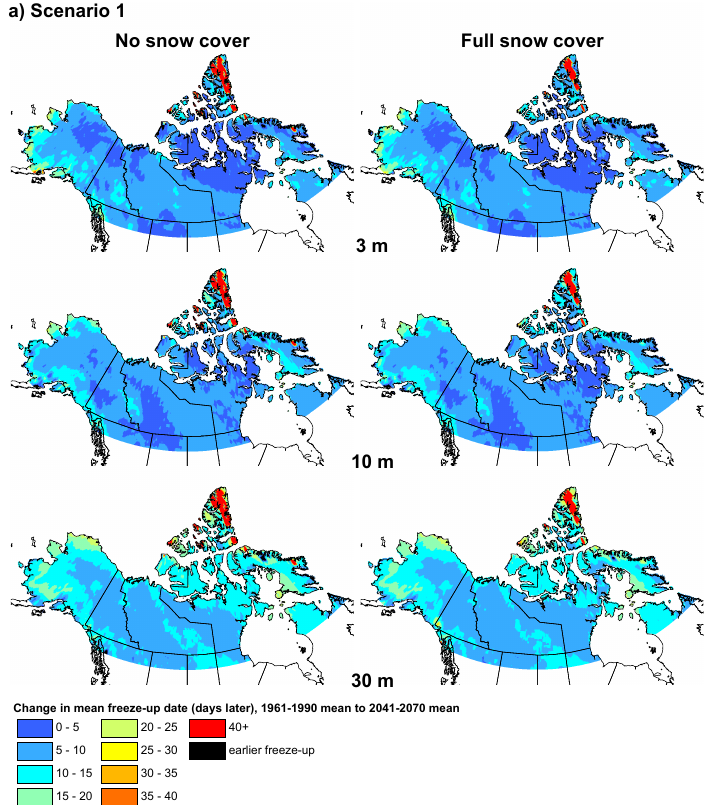
Fig. 11a. Change in mean freeze-up date from 1961-1990 to 2041-2070 for (a) scenario 1; (b) scenario 2; (c) the difference between the scenarios for the 2041–2070 mean freeze -up